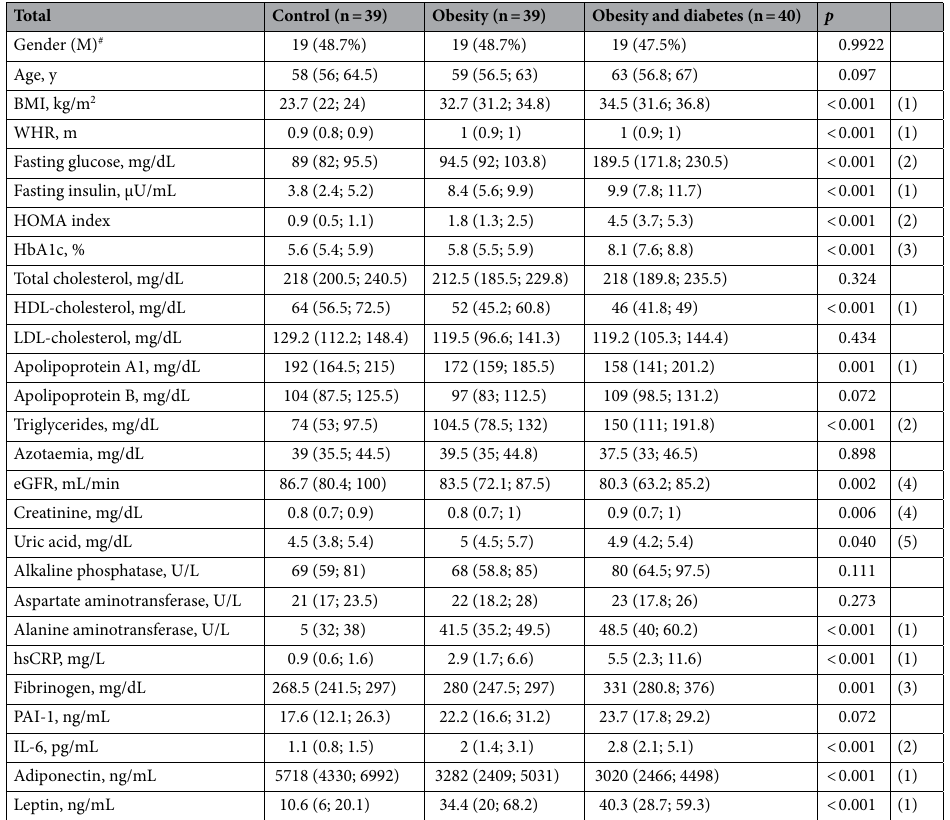
Table 1. Clinical characteristics of participants according to their health condition. Values are median and IQR; p value refers to Kruskal–Wallis test; # Values are absolute and percent frequencies; p value refers to Chi-square test. Multiple comparisons: (1) Obesity, Obesity and Diabetes versus Control; (2) Obesity, Obesity and Diabetes versus Control; Obesity and Diabetes versus Obesity; (3) Obesity and Diabetes versus Control, Obesity; (4) Obesity and Diabetes versus Control; (5) Obesity versus